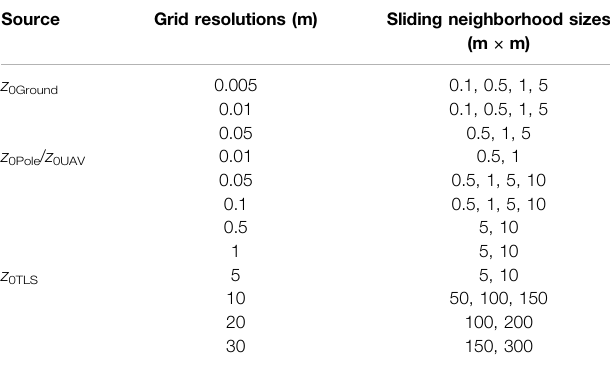
TABLE 2 | List of grid resolutions and sliding neighborhood sizes used in multi- scale